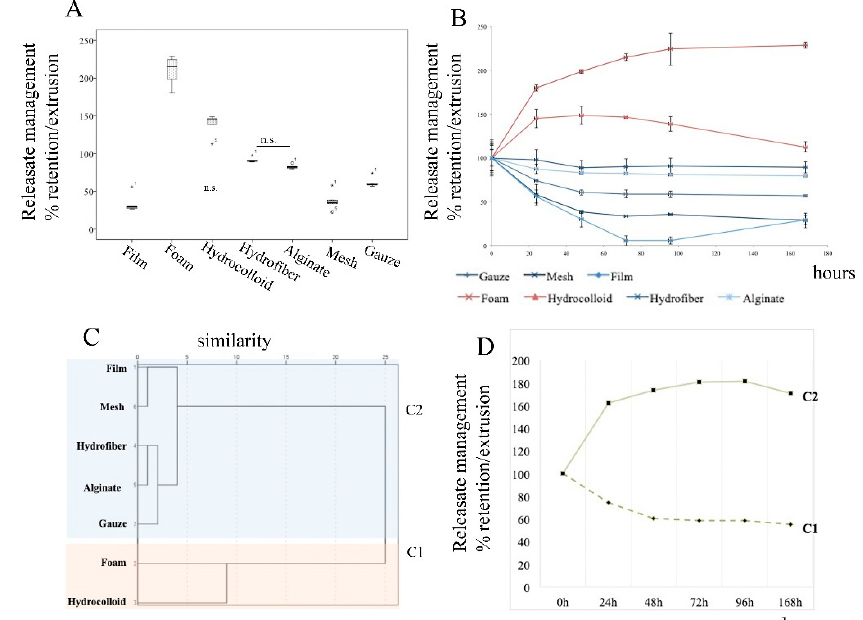
Figure 2. ( A ) Releasate management (uptake/release) differed between dressings, p < 0.001 for all comparisons except “hydrofiber versus alginate” and “film versus mesh”, which were non-significant (n.s.) differences. Box plots depict the median, lower and upper quartile, symbols outside the box represent outliers; ( B ) Percent retention/extrusion of the releasate over 7 days; ( C ) Dendogram showing the hierarchical relationship between dressings, the X axis is a measure of closeness of either individual dressings or clusters; cluster analyses reveal two groups of dressings, C1 (pink background) and C2 (blue background); ( D ) Cluster differences in releasate management measured over 7 days.